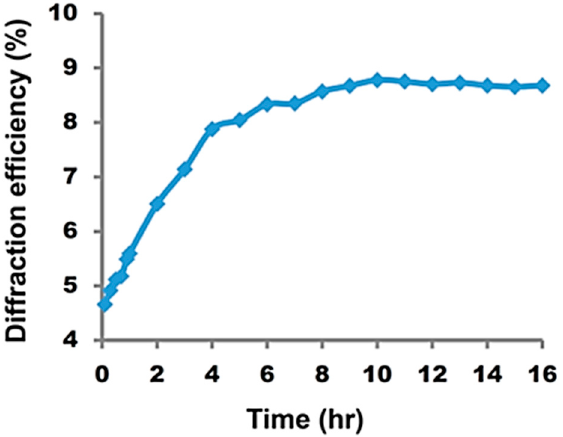
Figure 4. Dynamic variation in the measured diffraction efficiency of the LC/monomer grating sample with the observation time at T R .